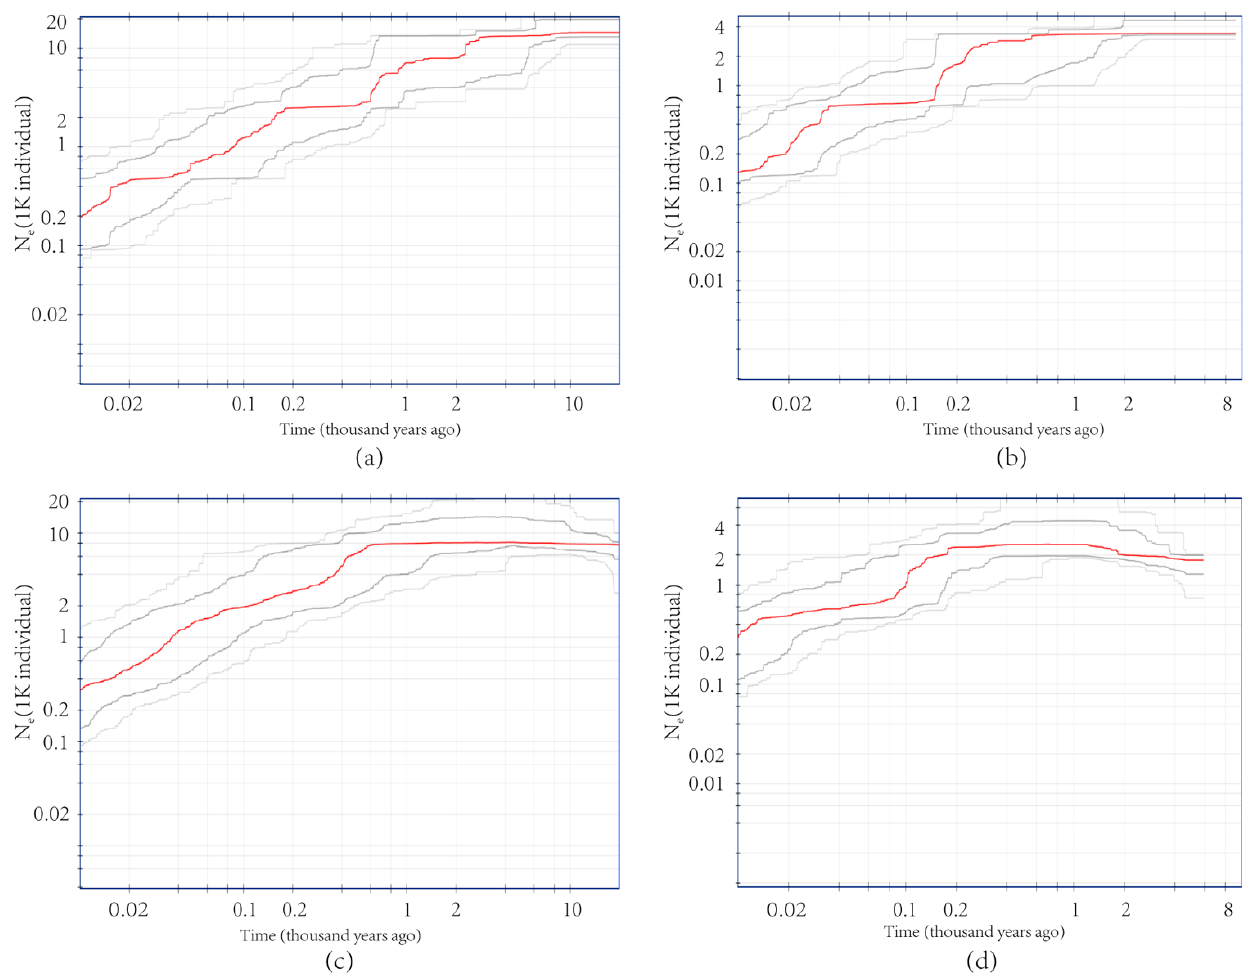
Figure 2. Demographic inference by stairway plot . The x-axis is the time in thousands of years or generations from the present to the past. The y-axis is the N e in thousand individuals. The red line indicates the median estimate of effective population size, and the dark and light grey lines indicate 75% and 95% confidence intervals, respectively. ( a ) Wild populations with mutation rates as 1.3 × 10 − 9 . ( b ) Wild populations with mutation rates as 5.2 × 10 − 9 . ( c ) Cultivars with mutation rates as 1.3 × 10 − 9 . ( d ) Cultivars with mutation rates as 5.2 × 10 − 9